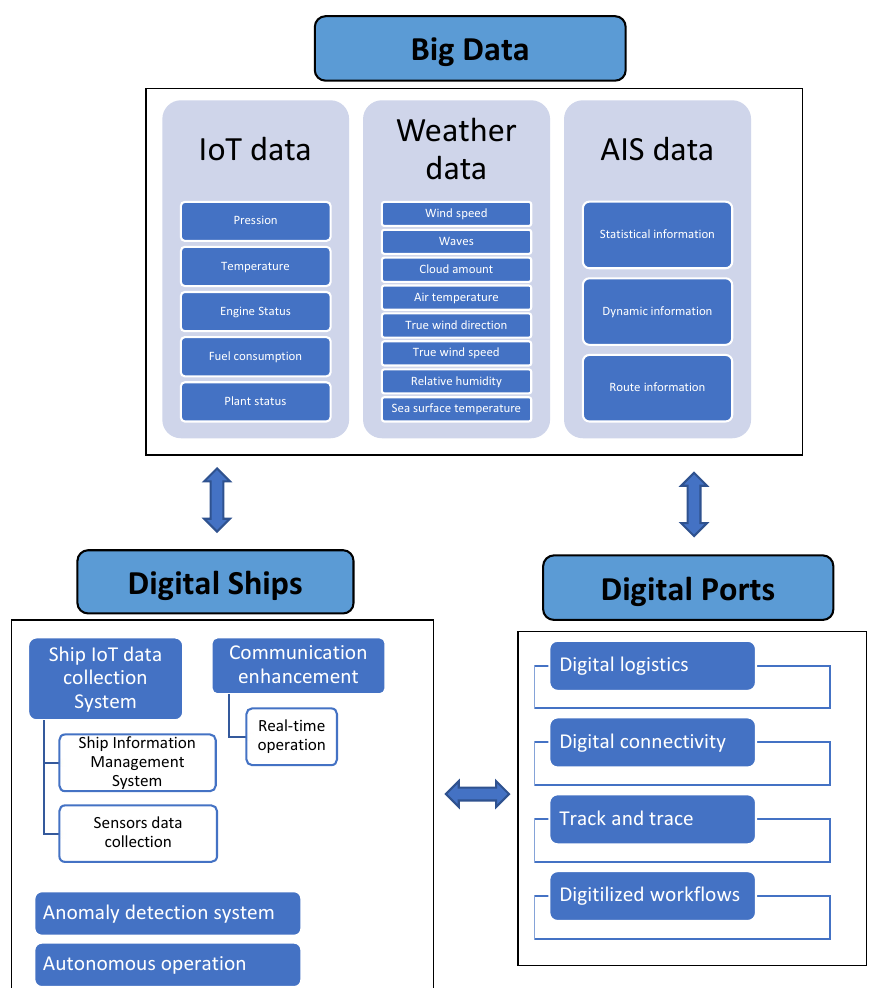
Figure 11. Digitalisation of maritime